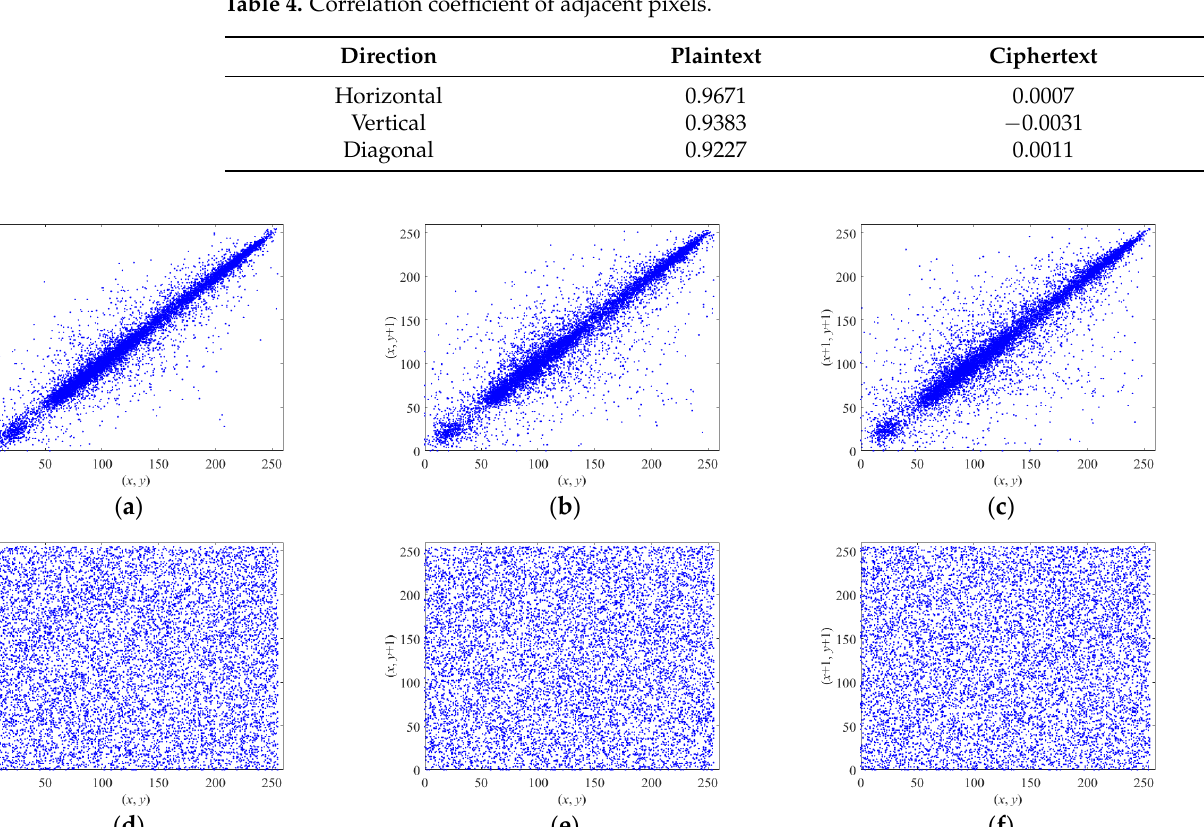
Table 5. Correlation coefficient of adjacent pixels. Table 4. Correlation coefficient of adjacent pixels.